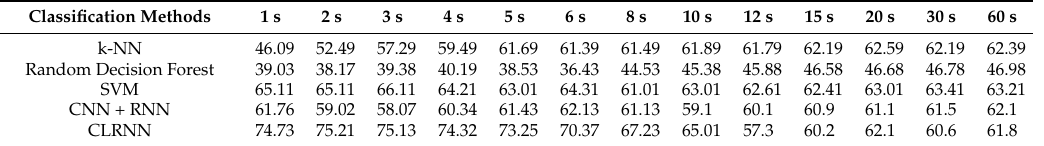
Table 5. The classification results with different time window size and methods.